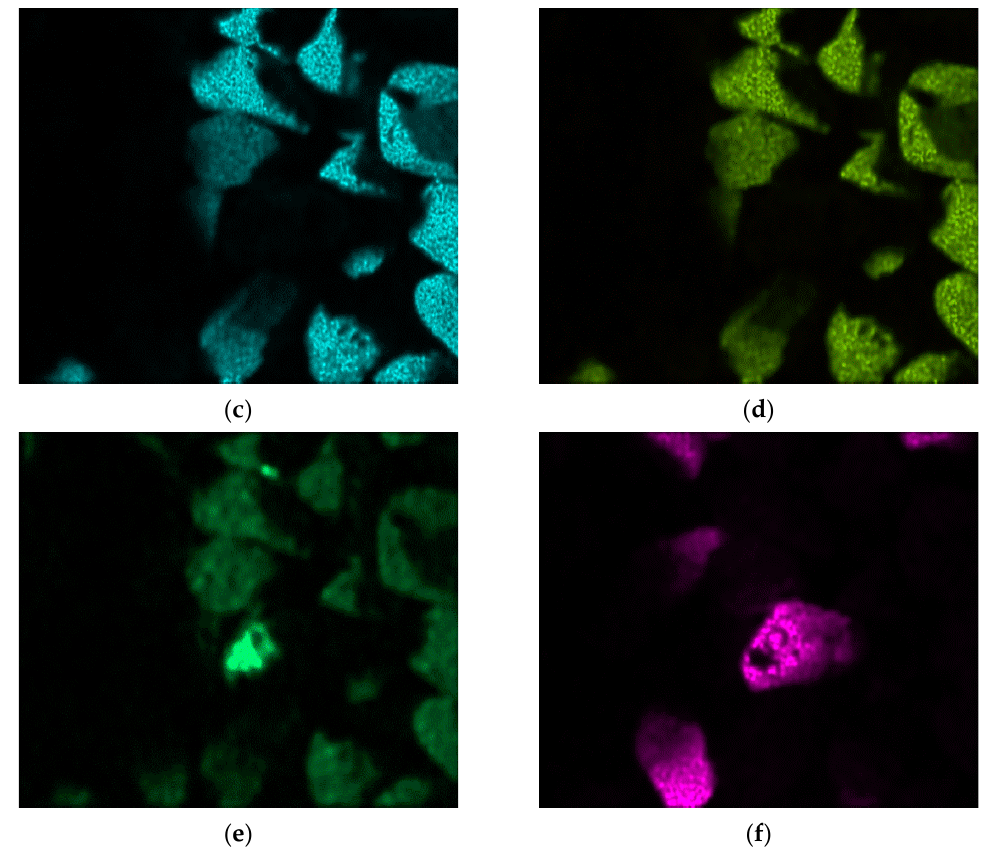
Figure 14. Distribution of the elements: ( a ) fraction 6; ( b ) distribution of the elements on the surface; ( c ) zirconium; ( d ) phosphorus; ( e ) hafnium; ( f ) titanium.